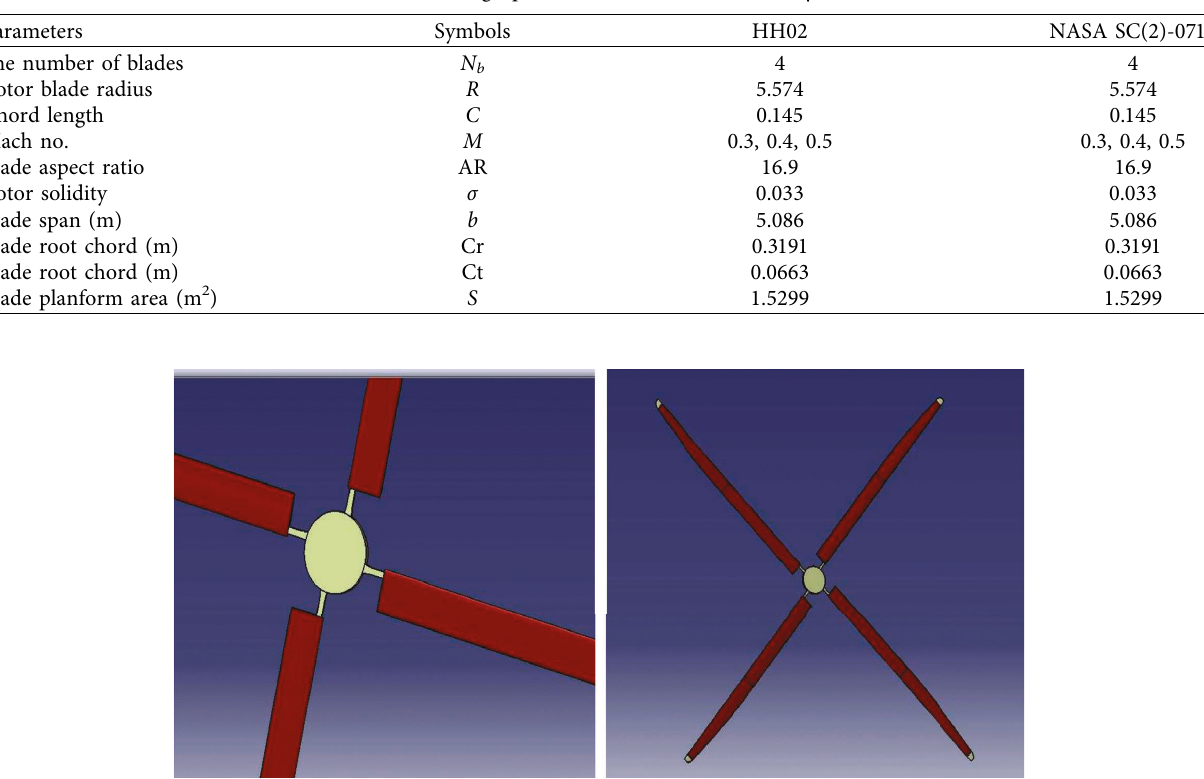
Table 1: Design parameters for four-bladed analysis.